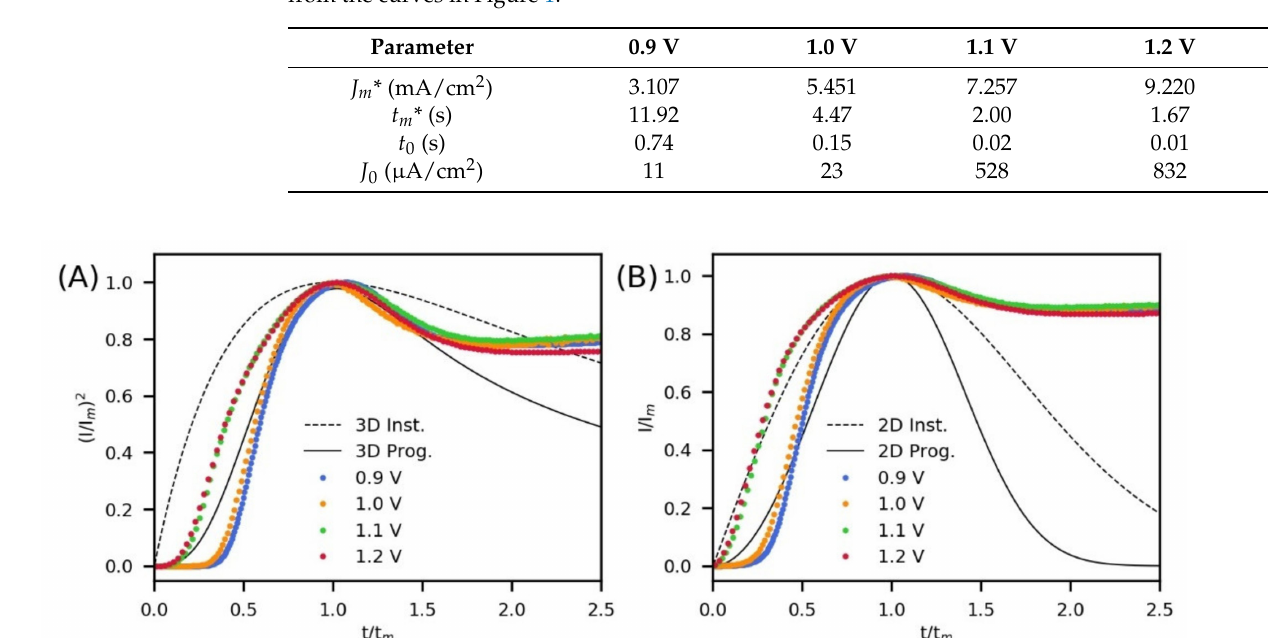
Figure 2. Dimensionless plots of maximum currents (Figure 1) and theoretical curves for instantaneous and for progressive nucleation with ( A ) 3D growth and ( B ) 2D growth during the electrosynthesis of